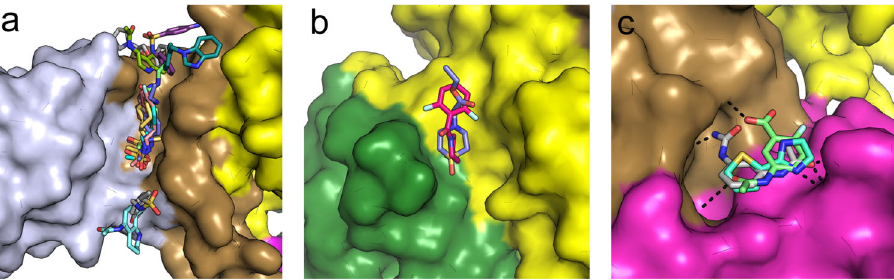
Fig. 5 Fragments bound on the interfaces between domains that appear to move as part of the catalytic cycle and thus may be starting points for allosteric inhibitor design. a Surface view of a prominent fragment binding site which bound to 11 fragments in a cleft between the Zinc and Stalk domains with the domains colored individually as for the color scheme in Fig. 1. b Two fragments were observed to bind in a cleft between the 1A and 2A domains approximately opposite the hinge. c Three fragments were bound in a shallow pocket between the Stalk and 1B domain (also close to the RNA interface) and make polar contacts to both